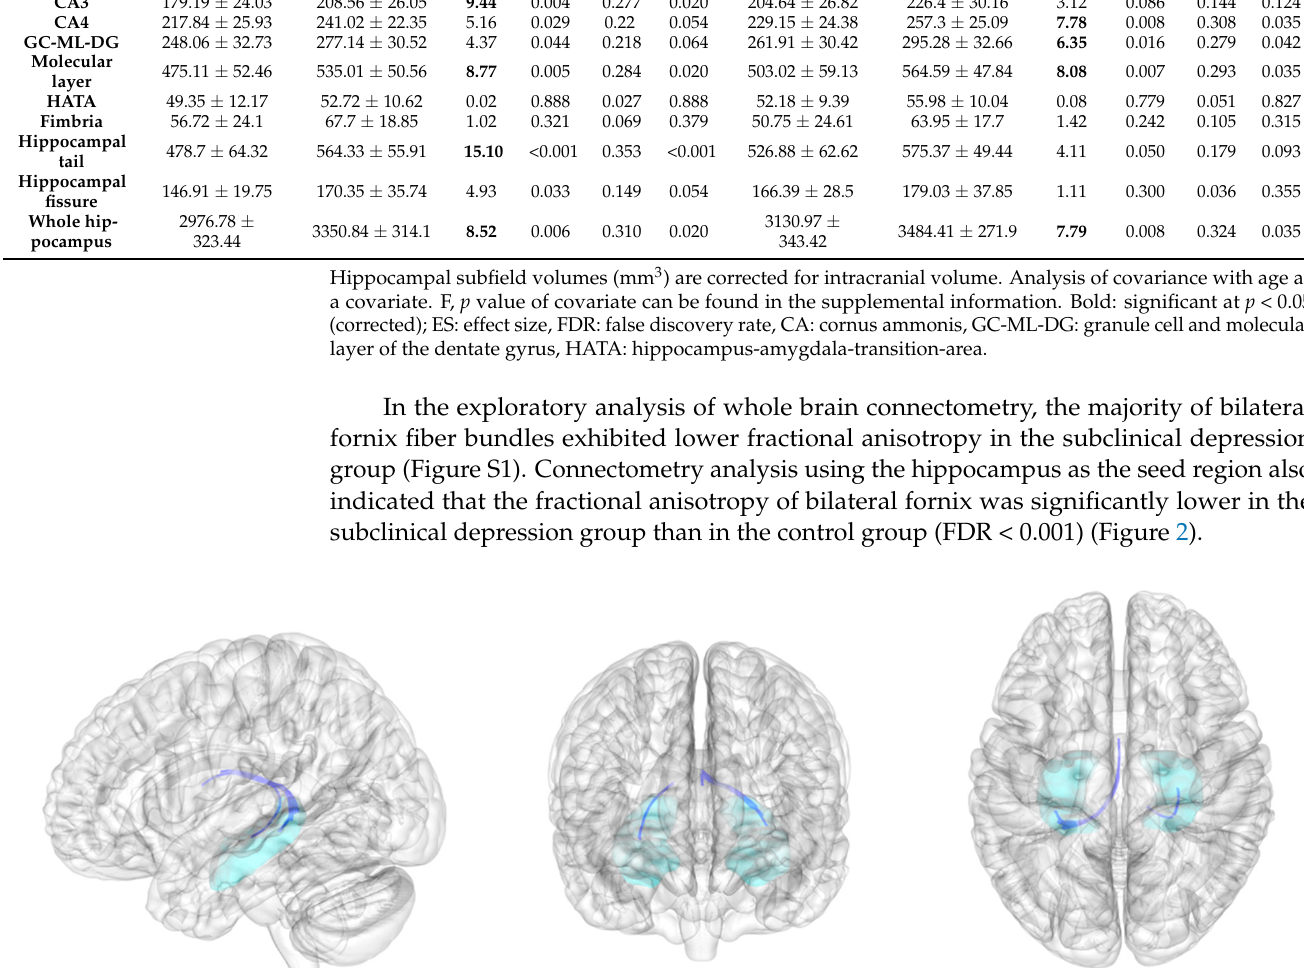
Standardized scores on the word-list learning test were positively correlated with the volumes of the CA1 (cor = 0.563, corrected p = 0.043), GC-ML-DG (cor = 0.560, corrected p = 0.042), molecular layer (cor = 0.627, corrected p = 0.039), and whole hippocampus (cor = 0.605, corrected p = 0.039) of the right hemisphere in the subclinical depression group (Figure 3). However, there were no significant associations in the control group. The analysis of connectometry data indicated that the fractional anisotropy of the bilateral